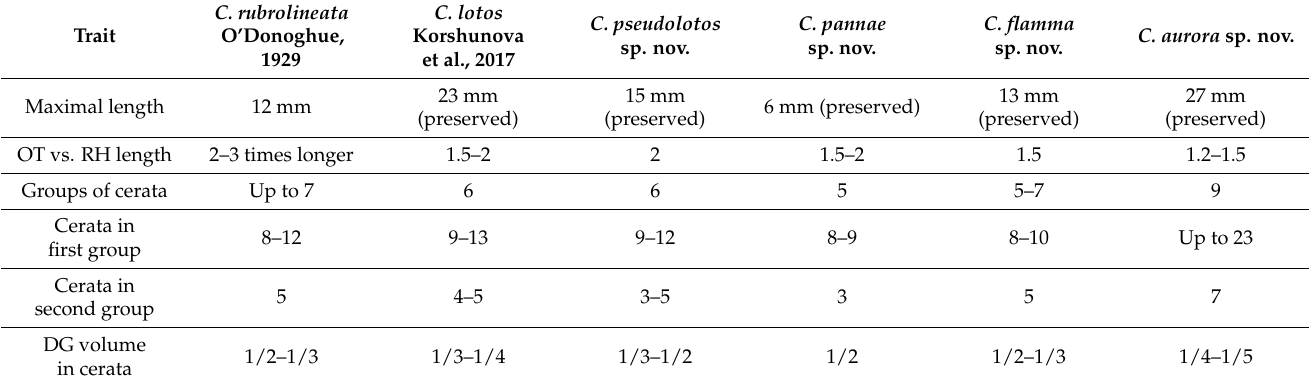
Table 2. Comparative morphology of species within Coryphellina rubrolineata species complex. Abbre- viations: OT = oral tentacles; RH—rhinophores; DG—digestive